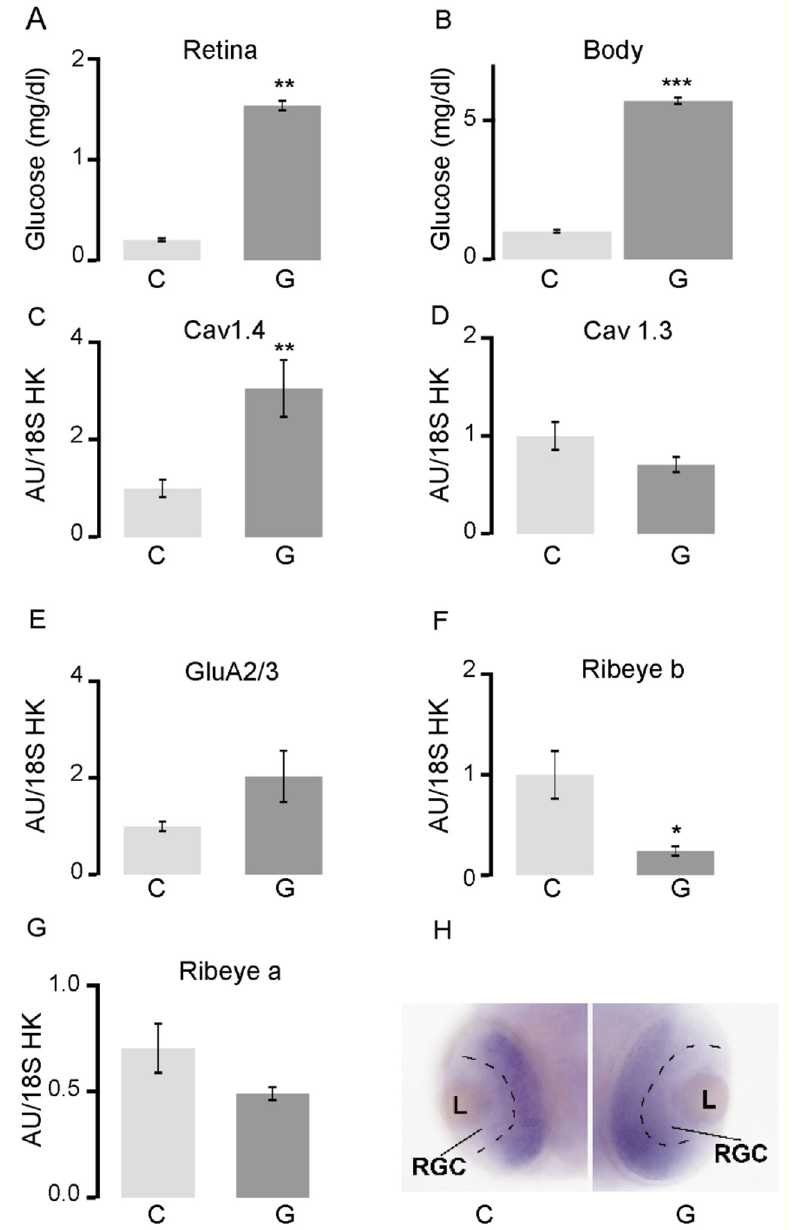
Figure 1. In zebrafish larvae, hyperglycemia results in altered transcription of retinal synaptic genes and localization of synaptic proteins. ( A ) Glucose concentration at 48 hpf in the retina and ( B ) in the rest of the body in embryos exposed to 4% glucose 24–48 hpf; ( C – G ) RT-qPCR analysis of the whole retina in embryos exposed to 4% glucose 24–48 hpf. All transcript levels were normalized to those of 18S rRNA. The levels of ca v 1.4a transcripts increased, those of ca v 1.3a, GluR2/3 , and ribeye a remained unchanged, while those of ribeye b decreased in retinas exposed to glucose, relative to controls; ( H ) In situ hybridization for ribeye a in the transverse sections in the center of the eye 48 hpf in control embryos ( C ) and those exposed to 4% glucose ( G ). The separation between the already defined retinal ganglia cell layer and the developing remainder of the retinal layer is marked by a black dashed line. * p < 0.05; ** p < 0.01; *** p < 0.001. Abbreviations: C, control; G, exposed to glucose; GluR2/3, glutamate receptor; hpf, hours post-fertilization; rRNA, ribosomal RNA; RT-qPCR, reverse transcription quantitative PCR; L, lens; RGC, retinal ganglion cells.